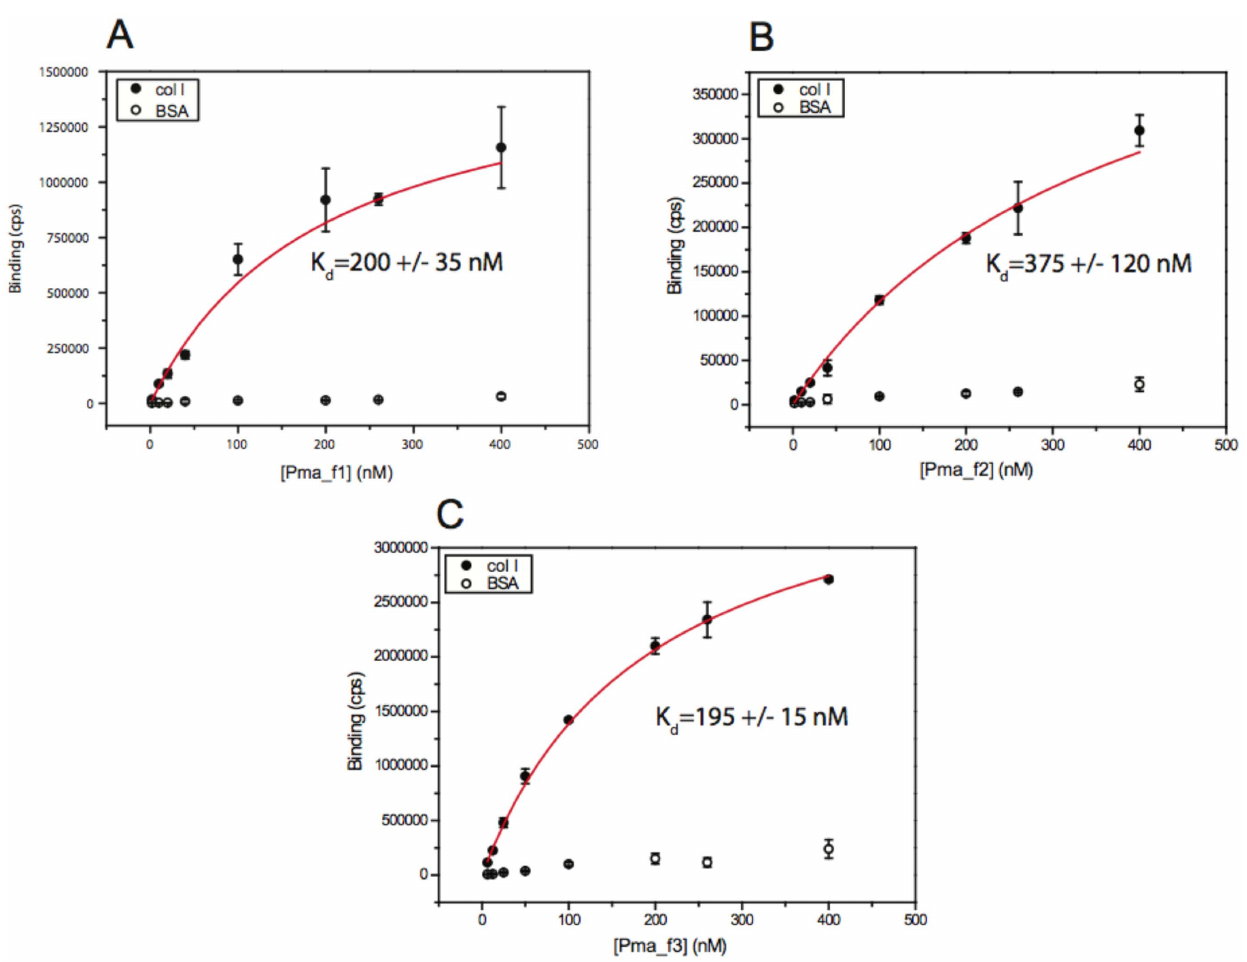
Figure 7. Binding of Pma_f a I domains to rat collagen I as a function of the concentration of Pma_f a I. (A–C) Binding affinities of Pma_f a I domains to rat collagen I were estimated by fitting binding data using a hyperbolic function, which is identical to Hill’s equation when h=1. BSA was used as a control.